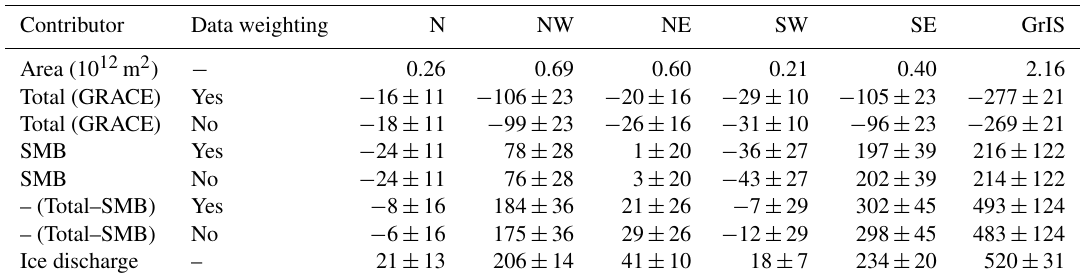
Figure 5. Mean monthly meltwater production per calendar month (gigatonnes) for the entirety of Greenland (a) , for individual drainage systems in gigatonnes (b) , and for individual drainage systems in meters of equivalent water height (c) modeled by RACMO2.3. Table 1. Linear mass change rates over the period 2003–2012 for individual drainage systems and the entirety of Greenland: total, SMB- related, and total–SMB residuals (GRACE–SMB), as well as ice discharge (Gtyr − 1 ). The sign of total–SMB residuals is changed to make them directly comparable with ice discharge